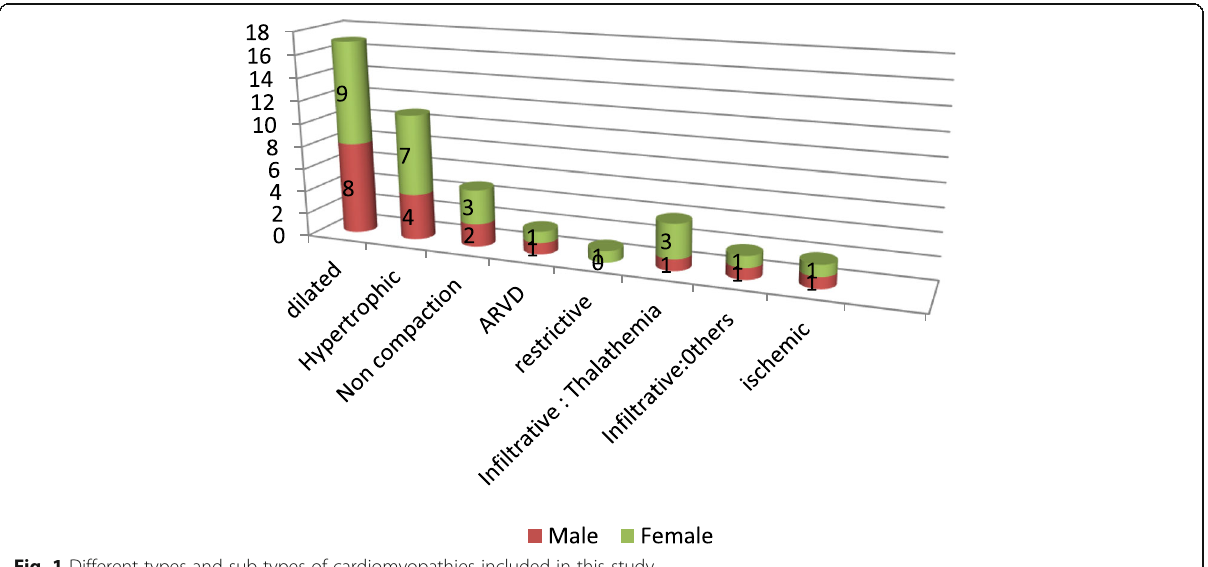
Fig. 1 Different types and sub-types of cardiomyopathies included in this